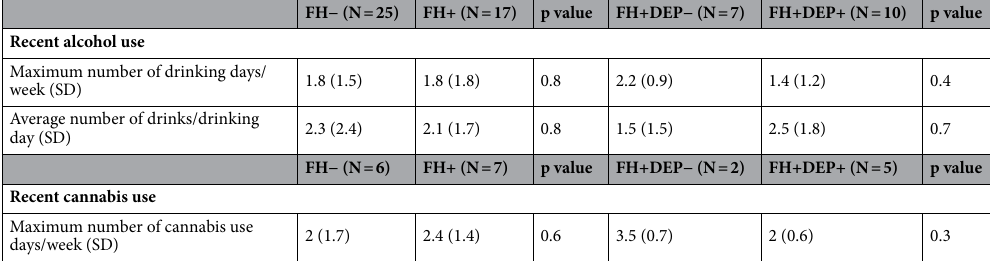
Table 2. Past month alcohol and cannabis use. Past month alcohol use [mean and standard deviation (SD)] stratified by group [bipolar disorder family history negative (FH−) vs. bipolar disorder family history positive (FH+) individuals who completed the Timeline Follow Back and reported lifetime alcohol use] and FH+ subgroups (FH+ individuals without a history of unipolar depression (FH+DEP−) vs. FH+ individuals with a history of unipolar depression (FH+DEP+) who completed the Timeline Follow Back and reported lifetime alcohol use]. Past month cannabis use stratified by group in individuals who completed the Timeline Follow Back and reported past month cannabis use. Between group differences were calculated using Mann–Whitney Wilcoxon